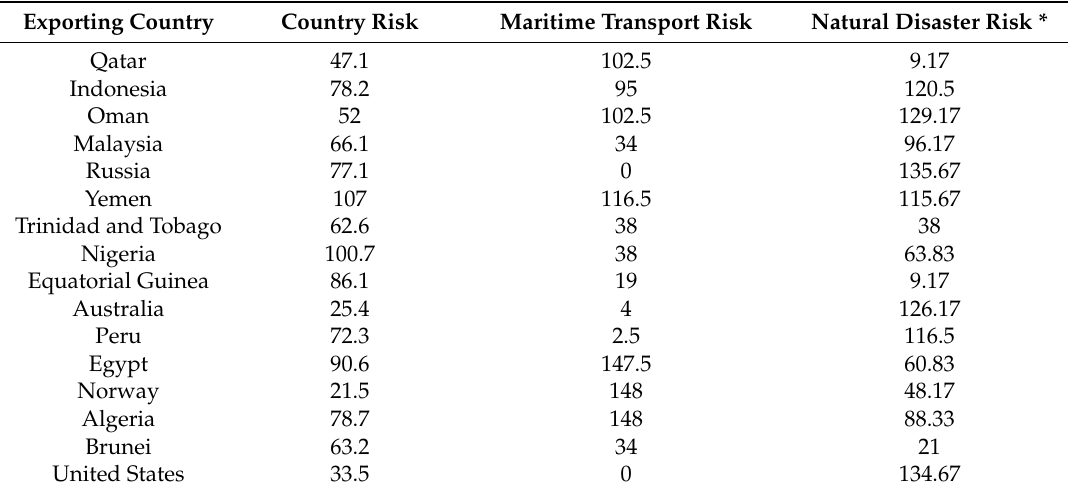
Table 6. The data on the intangible risks of the exporting